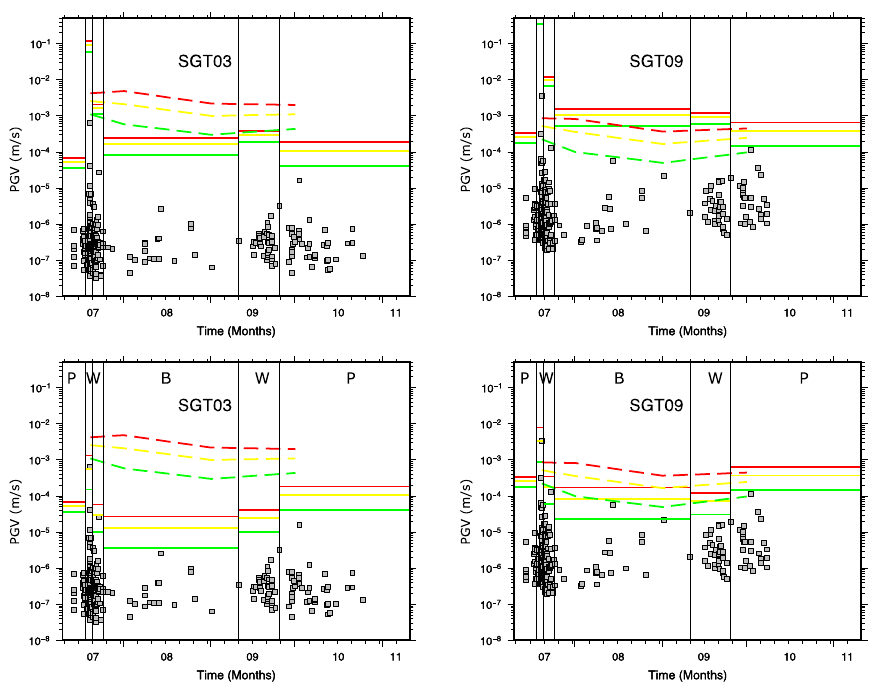
Figure 8. Same as Figure 7, but for 1.0 month exposure time.